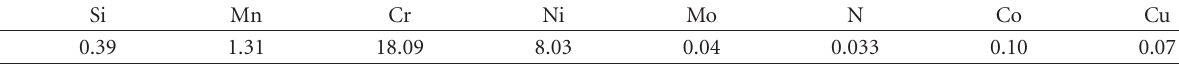
Table 1: Chemical composition of the AISI 304 austenitic stainless steel (% wt.).